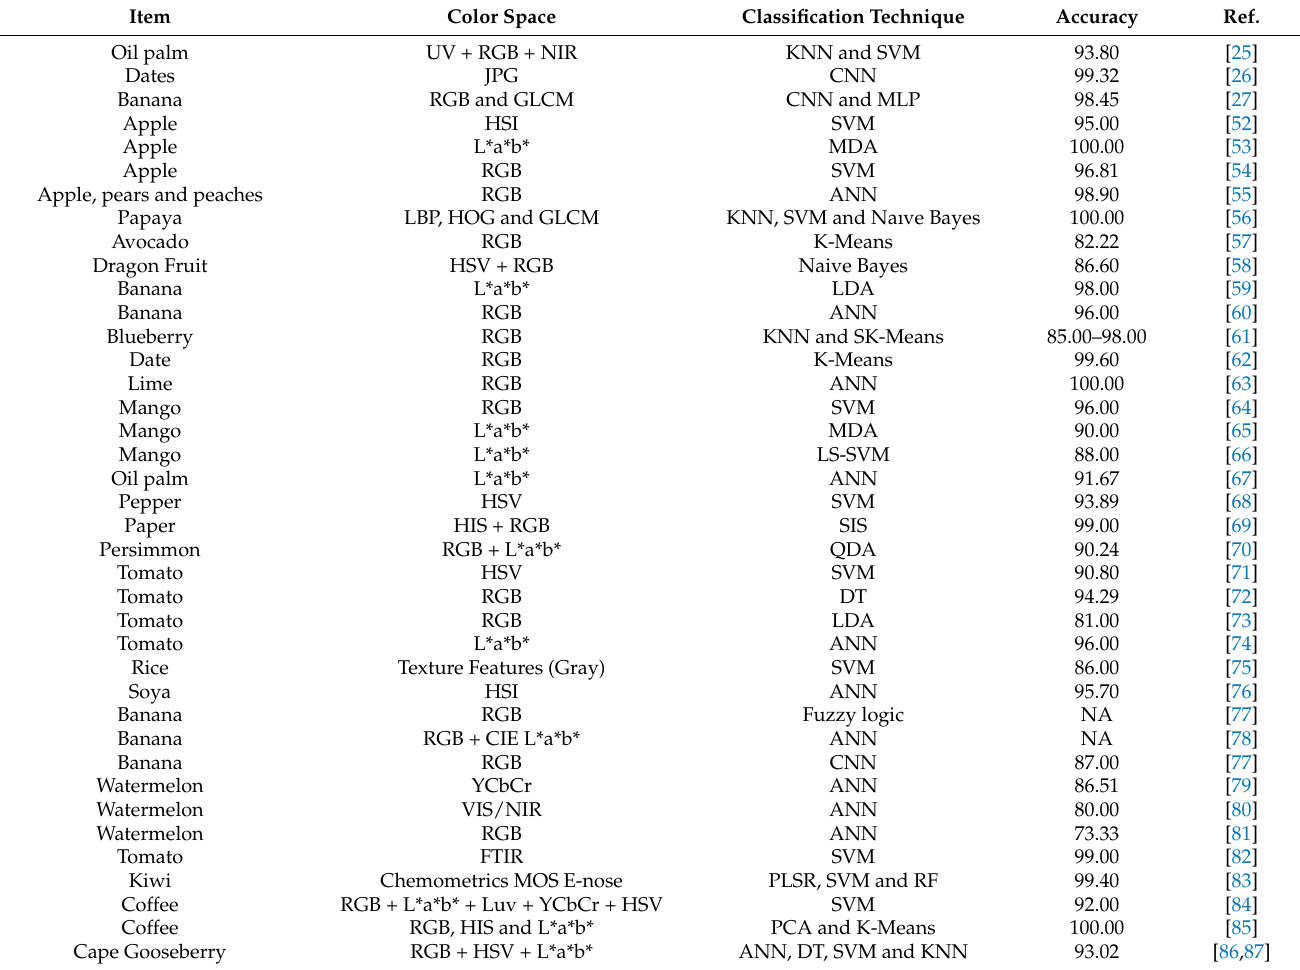
Table 1. The literature on accurately assessing crop quality using machine learning techniques based on a variety of color spaces. Table from Ref. [51] is cited and updated with new implementation results. Item Color Space Classification Technique Accuracy Ref.